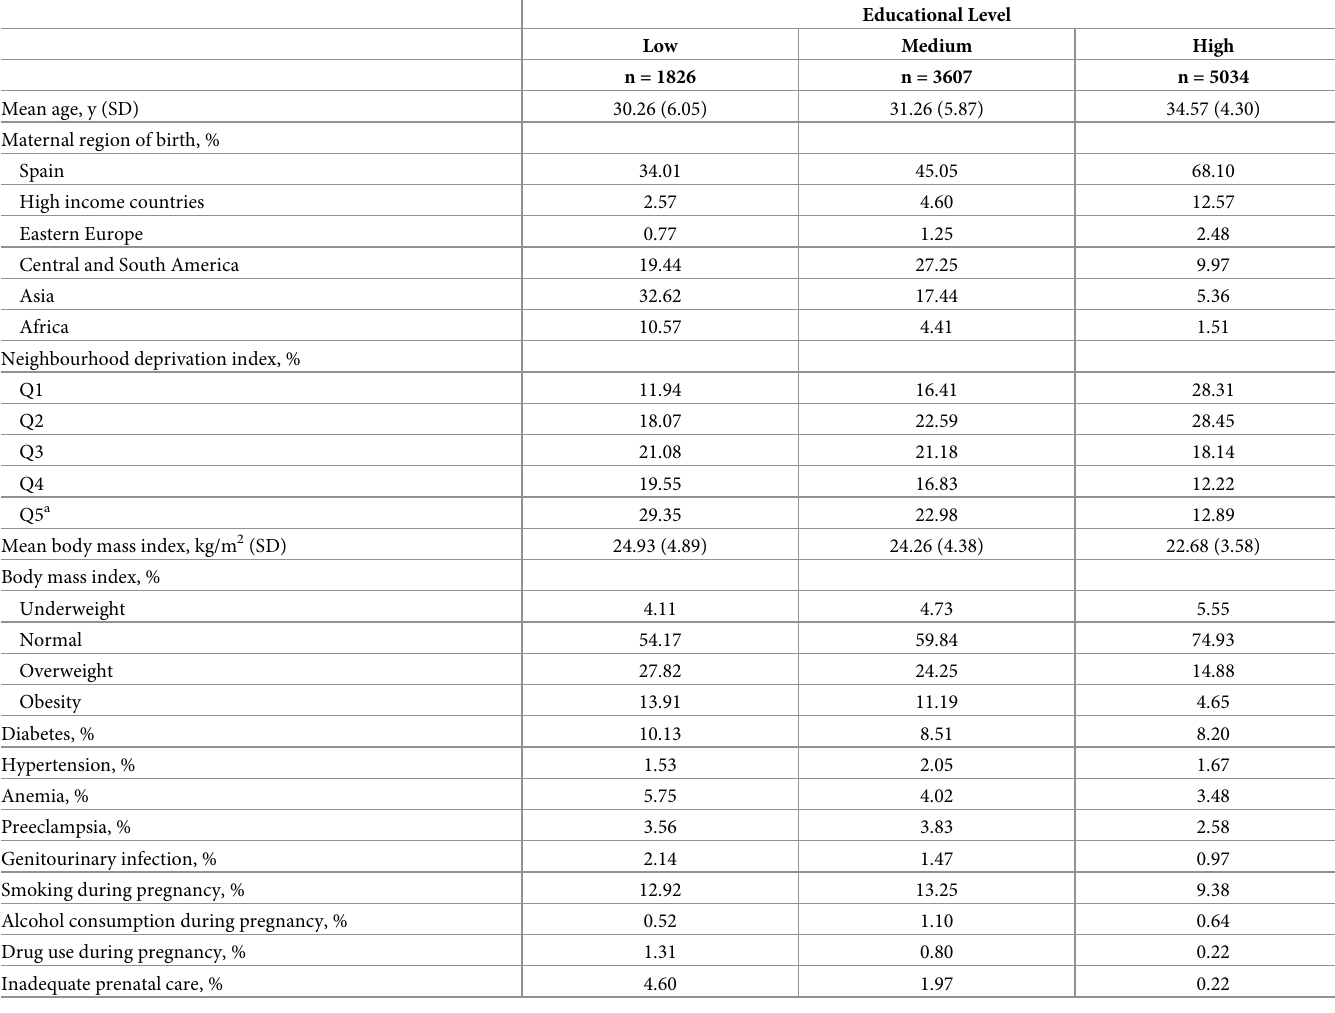
Table 1. Sociodemographic characteristics and pregnancy complications in participant women by educational